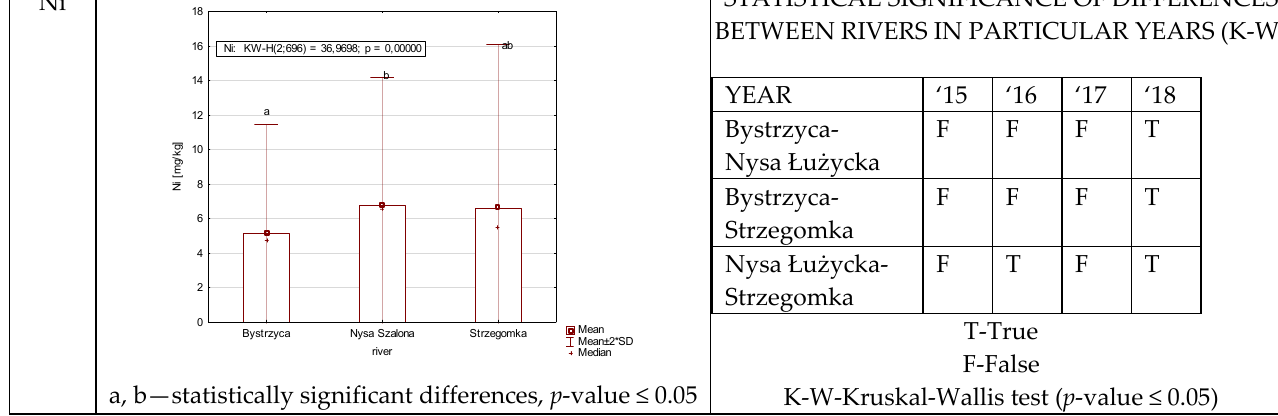
Figure 4. Ni concentration in plants from rivers across 29 sites depending on river (graph to the ( left )) and by year 2015–2018 in the table to the ( right ). Statistically significant differences are marked in the graph with letters a, b and in the table these differences are shown by year between rivers—T—differences were present, F—no statistical difference ( p -value ≤ 0.05).